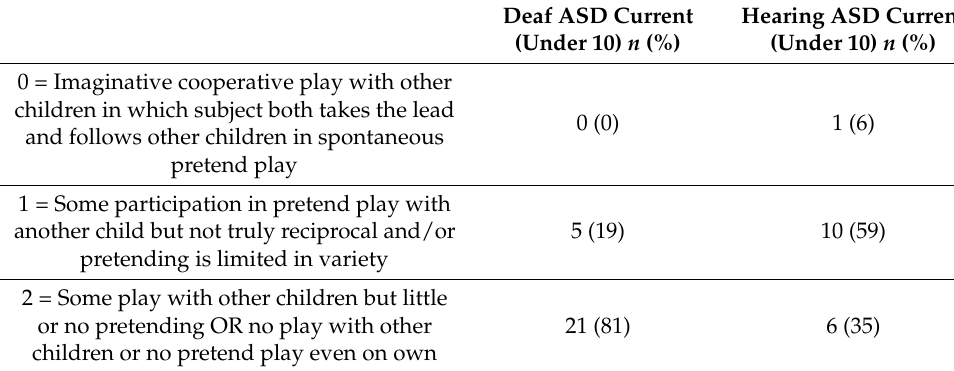
Table 5. Differences in imaginative play with